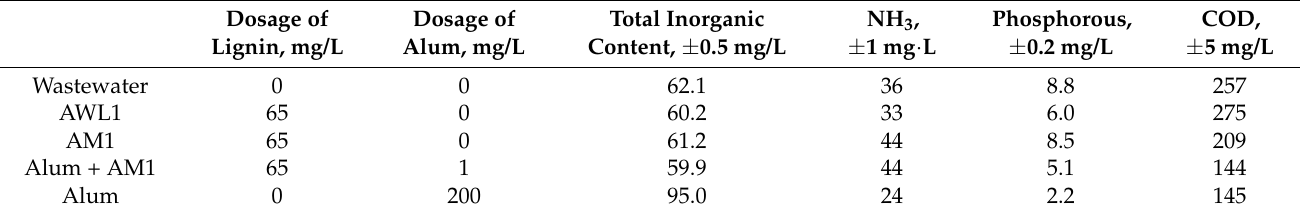
Table 6. Residual total inorganic content, ammonia, phosphorous, and COD in wastewater after